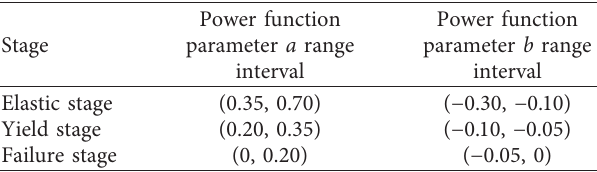
Figure 17: Relationship between energy dissipation coefficient of long spiral belled pile and cycle times under various loads. (a) ± 0.53kN. (b) ± 0.63kN. (c) ± 0.73kN. (d) ± 0.83kN. (e) ± 0.93kN. (f) ± 1.03kN. Table 5: Range of power function parameters in different loading